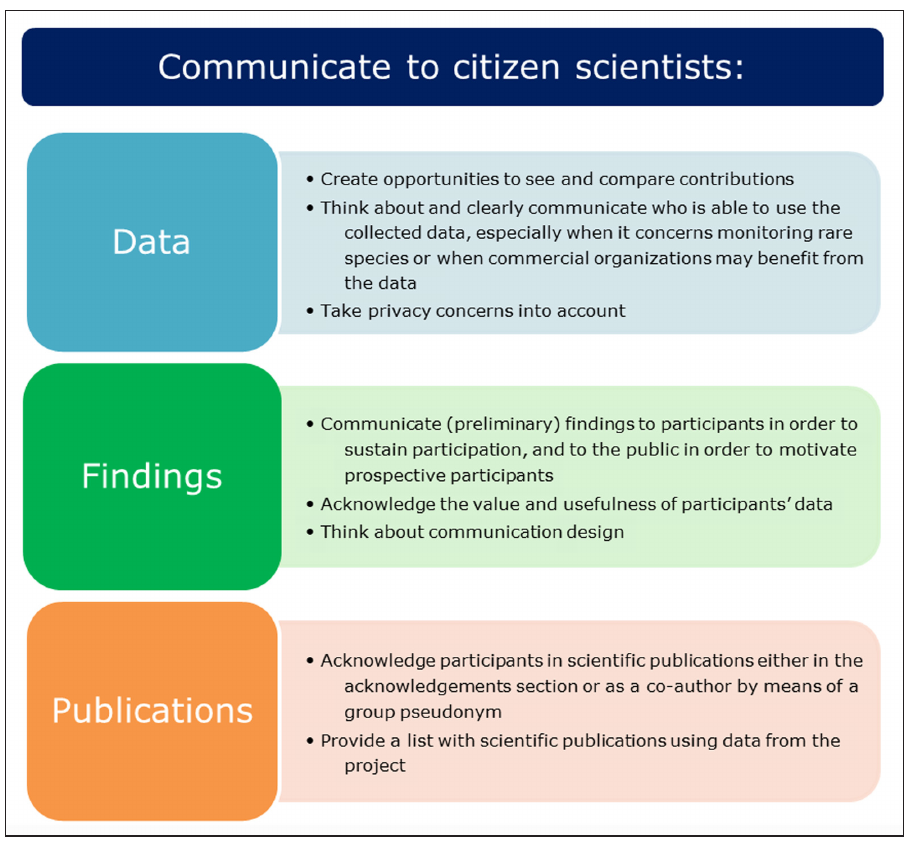
Figure 3: Key recommendations for citizen science project organizers based on our literature